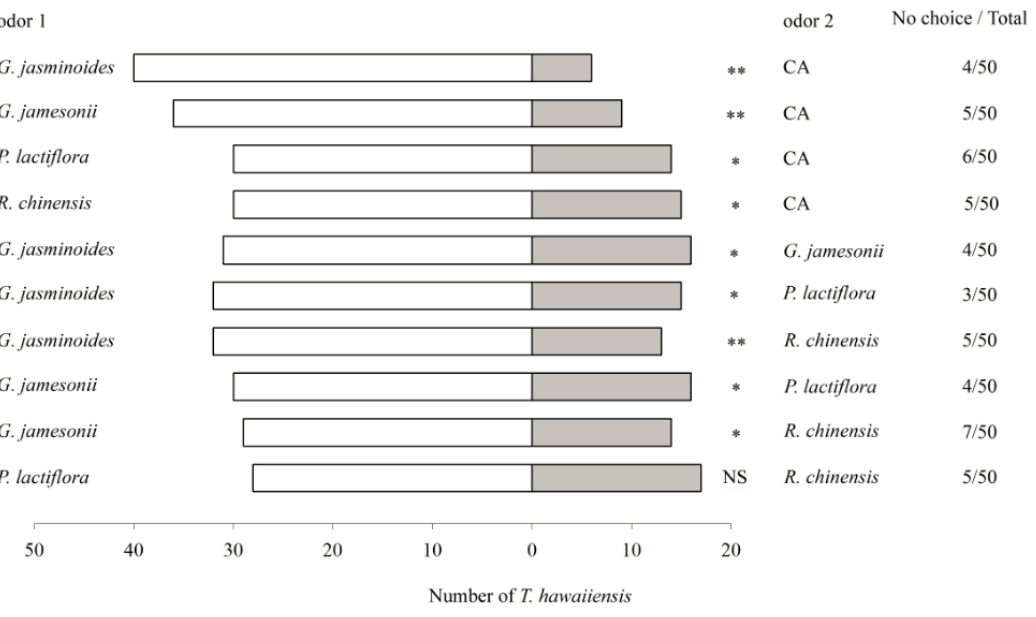
Figure 1. Behavioral responses of T. hawaiiensis to the volatiles from different flowers. Asterisks indicate highly significant (** p < 0.01) and significant (* p < 0.05) differences in the selectivity of T. hawaiiensis between two odors by χ 2 test. NS indicates no significant di ff erences ( p > 0.05) in the selectivity of T. hawaiiensis between two odors.